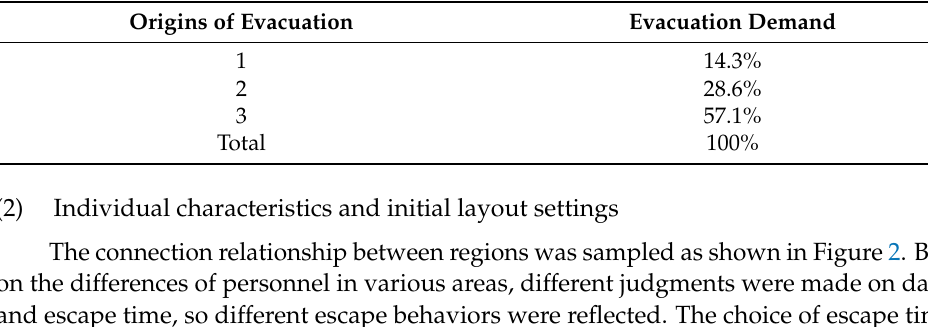
Table 3. Distribution of Escape Demand.